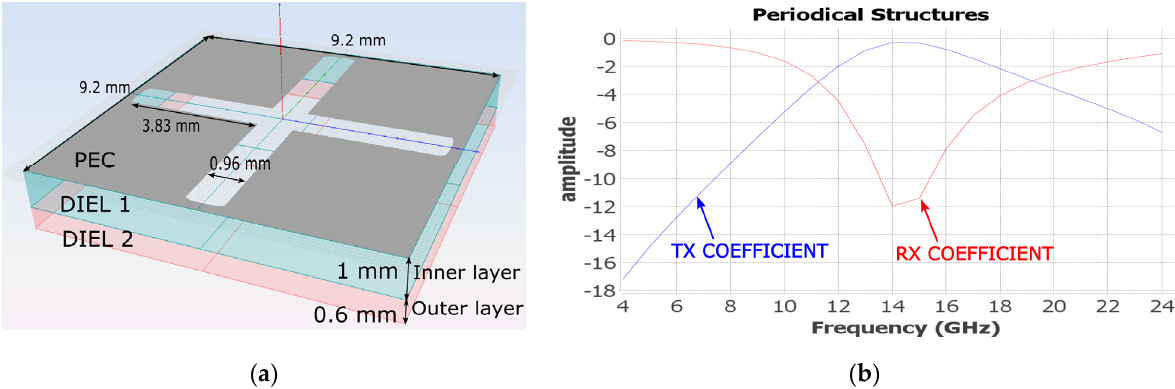
Figure 5. ( a ) Geometrical scheme of the FSS (frequency selective surfaces) unit cell (planar); ( b ) re-flection and transmission coefficients on an infinite planar layout for a frequency sweep between 4 GHz and 24 GHz.